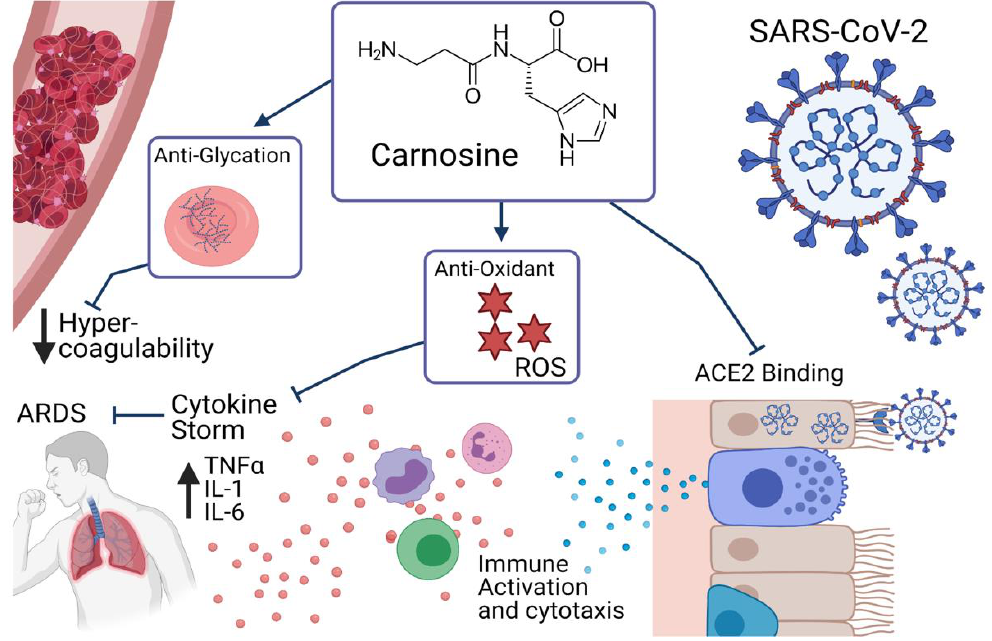
Figure 1. Effects of carnosine in relation to COVID-19.